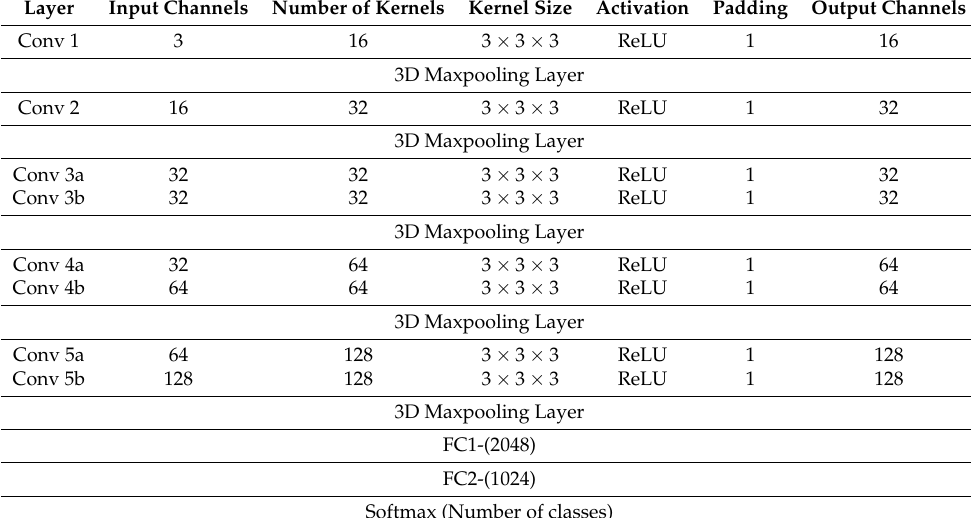
Table 2. Architectural details of the proposed 3DCNN student Model.